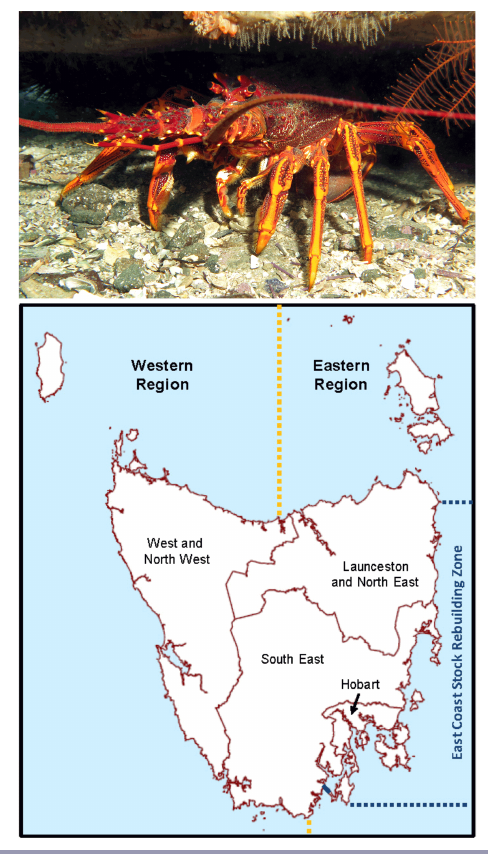
Fig. 1 . Map showing Tasmanian Australian statistical geography standard statistical areas rock lobster fishing regions and the current (2019) east coast stock rebuilding zone. Map taken from (Lyle